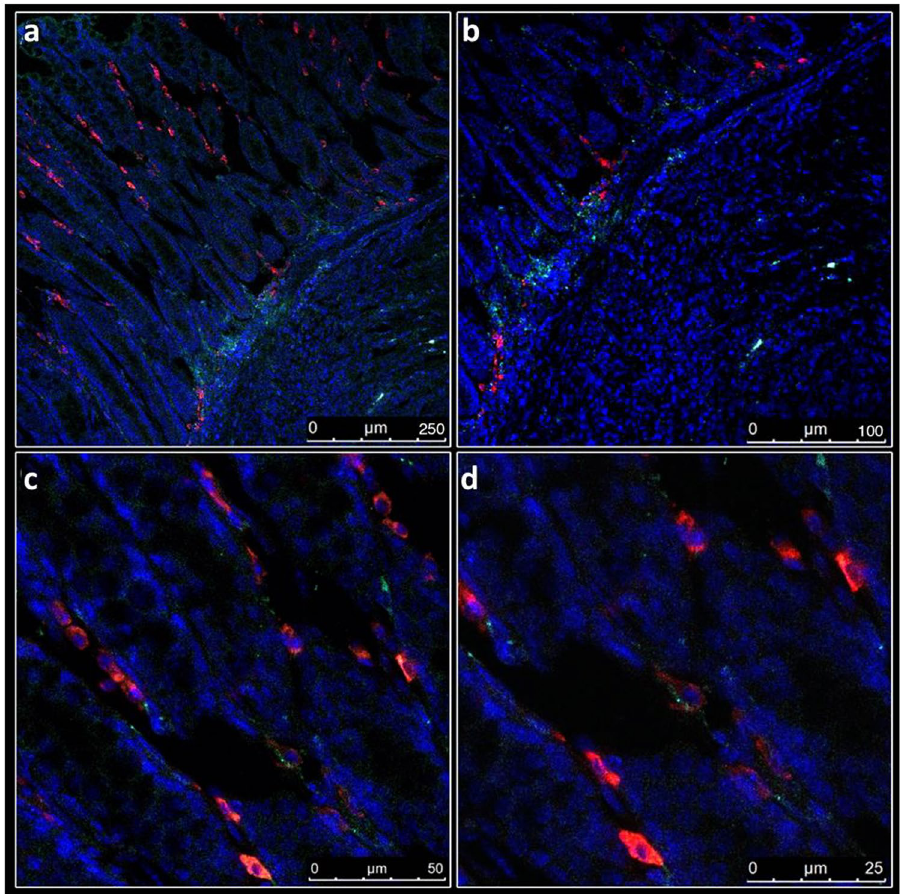
Figure 6. Fluorescence microscopy of ICG in tumor and normal tissue. ( a ) ICG (green) extravasated blood vessels (red, anti-CD31; blue DAPI) at the tumor margins. It may also diffuse into the tumor, as shown in lower left, x200 magnification. ( b ) Higher magnification (x350) of A. ( c ) In normal mucosa ICG is seen in the blood vessels (x600). ( d ) Higher magnification of C, showing ICG retained in capillaries (x1000). Mice were i.v. injected with PEG-Lip-ICG and signal intensity determined after 12